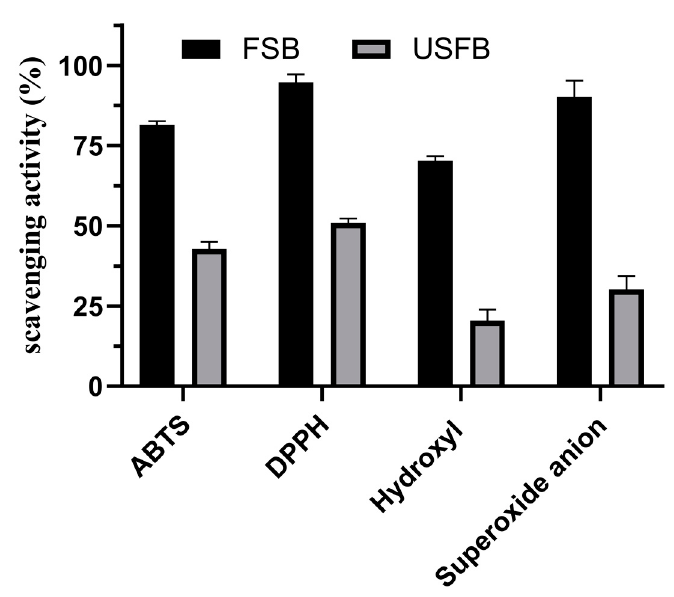
Figure 1. Antioxidant capacity of soy beverage with N. aurantialba .